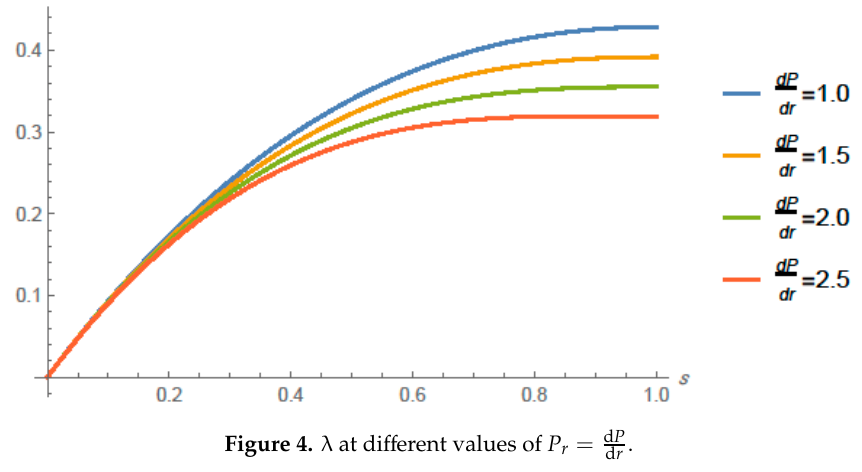
. d r (cid:2914)(cid:3045)